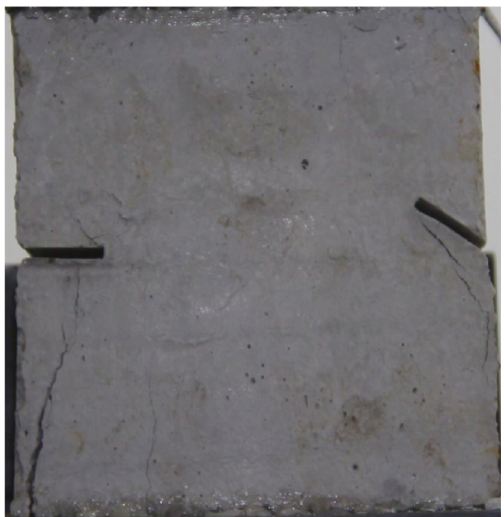
Figure 16. Photograph of a specimen showing another set of anti-tensile wing crack appearing.